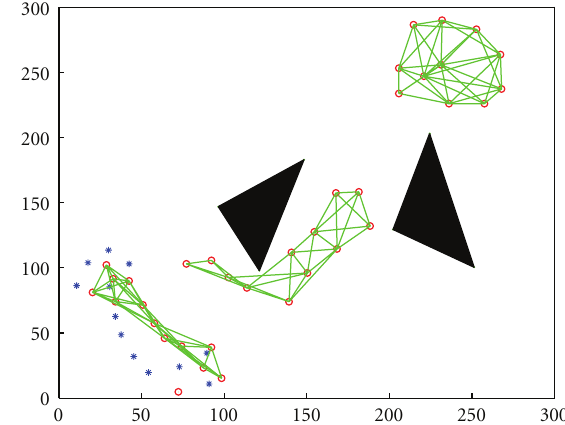
Figure 9: A swarm of 12 robots maintaining a specified commu- nication graph. Beginning in the upper right corner and moving toward the lower left